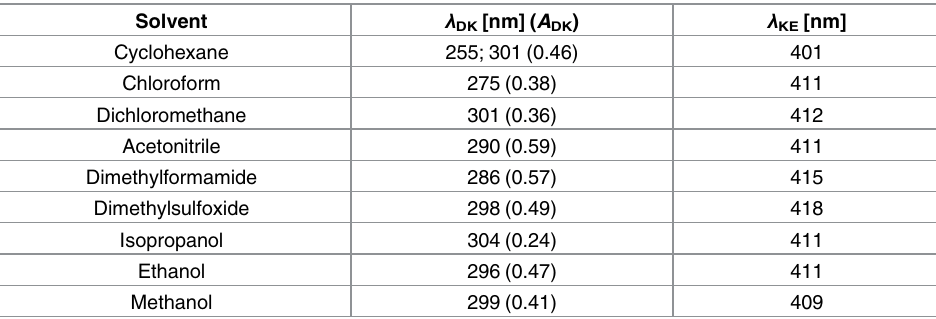
Table 2. Absorption properties of K2T23.